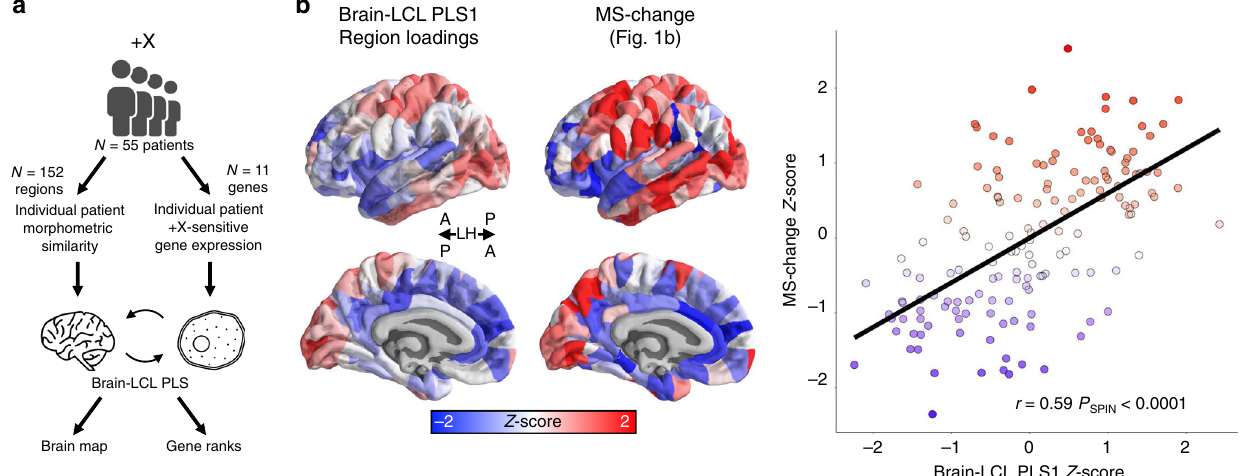
Fig. 4 Altered gene expression predicts regional anatomical change across patients. a Schematic outlining the analytic approach to interrelating cortical MS changes from MRI and DS gene expression from LCLs in + X patients. b (left) Regional loadings for principal component of shared variance between MS change in brain and DS gene expression in LCLs. (middle) Regional MS change in + X patients compared to controls (from Fig. 1a). Spatial similarity between these maps indicates that + X patients with greater dysregulation of DS genes in blood show a more pronounced manifestation of the + X MS change map. (right) This spatial similarity is quantitatively strong ( r = 0.59) and statistically signi fi cant ( P SPIN <